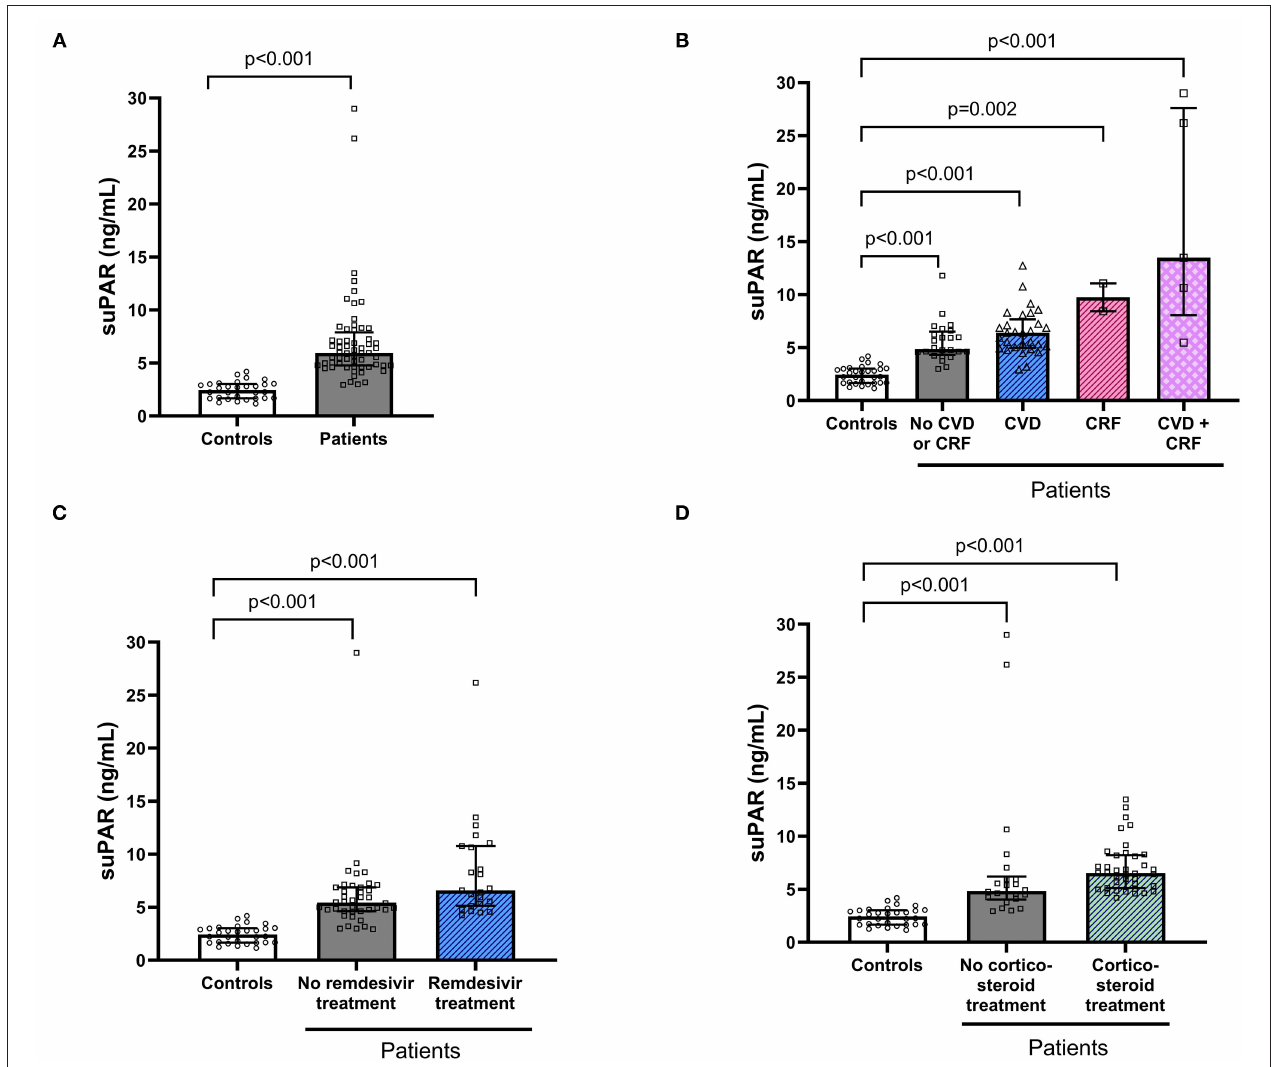
FIGURE 1 | Soluble urokinase plasminogen activator receptor (suPAR) levels in controls and patients hospitalised with COVID-19. suPAR serum concentration was compared between individuals hospitalised with COVID-19 and healthy age- and sex-matched controls (A) . COVID-19 patients were also stratified based on comorbidities (B) and treatments (C,D) of importance for suPAR levels and thereafter compared with the control group. Bars and error bars show median and inter quartile range. Dots represent individual values. suPAR, soluble urokinase plasminogen activator receptor; CVD, cardiovascular disease; CRF, chronic renal